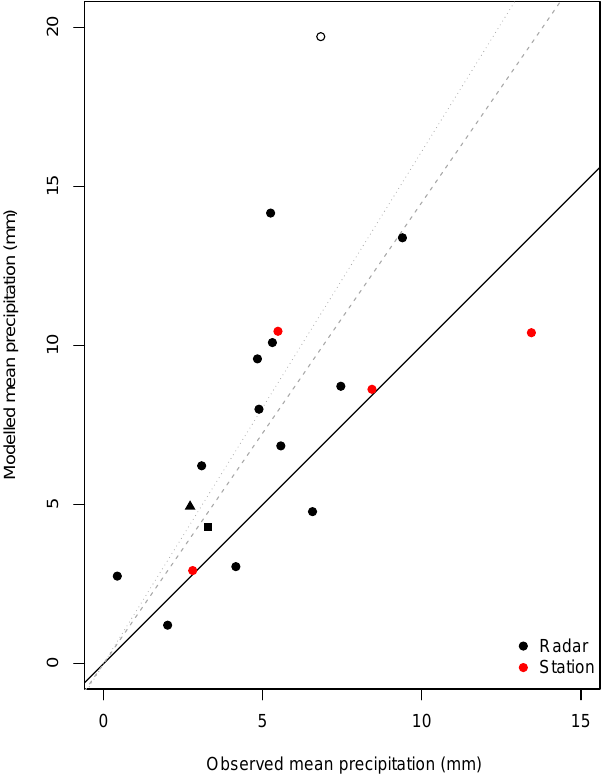
Figure 4. Scatterplot of observed and modeled daily mean precip- itation (mmday − 1 ) by radar (black, 00:00–00:00UTC) and at sta- tions (red, 08:00–08:00UTC) over the Netherlands. The dotted and dashed lines give a linear regression between precipitation modeled and observed by radar, respectively, including and excluding the day indicated with an open dot (30 June 2003). The days with a square (22 July 2007) and triangle (29 July 2000) are illustrated spatially in Fig. 5. The solid 1:1 line represents a perfect